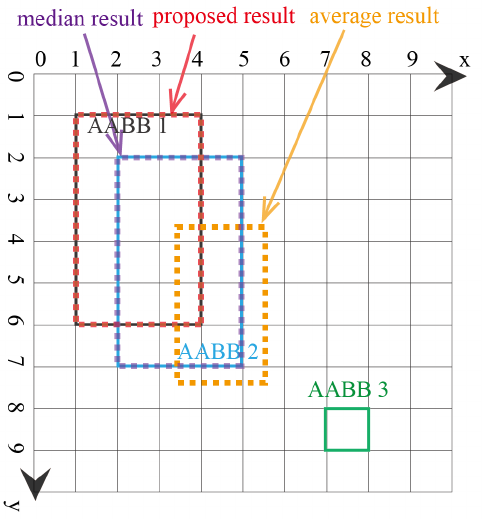
Figure 9. Third example of fusing three AABBs with one extreme outlier.